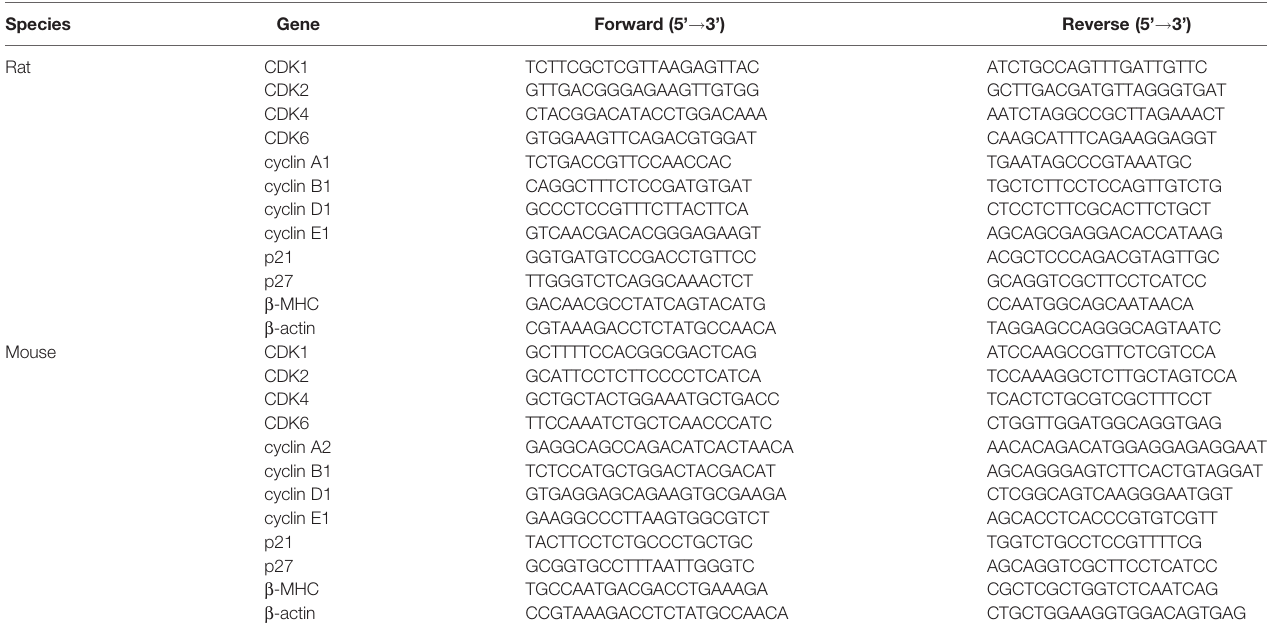
TABLE 1 | Primers used for real-time RT-PCR.